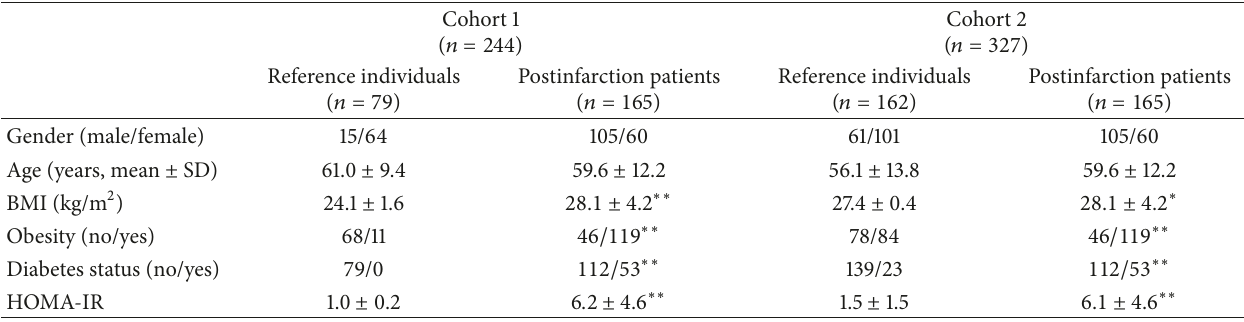
Table 1: Subject characteristics.